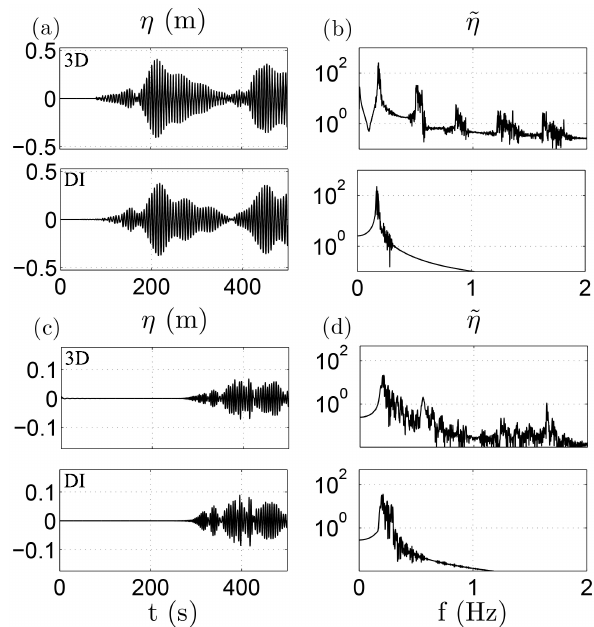
Figure 9. Free-surface time series (left column) and their relative frequency spectra (right column) at the CP point ( a and b ) and at P point ( c and d ). Comparison between the solution of the 3-D ref- erence model (upper plots) and the solution of the depth-integrated equation (lower